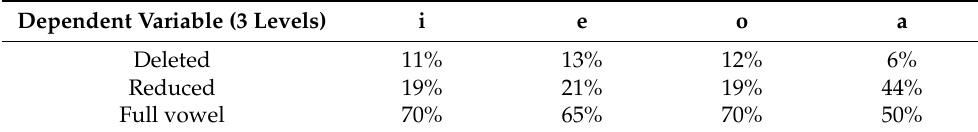
Table 4. Distribution of surface forms by final-vowel identity (N = 2477).